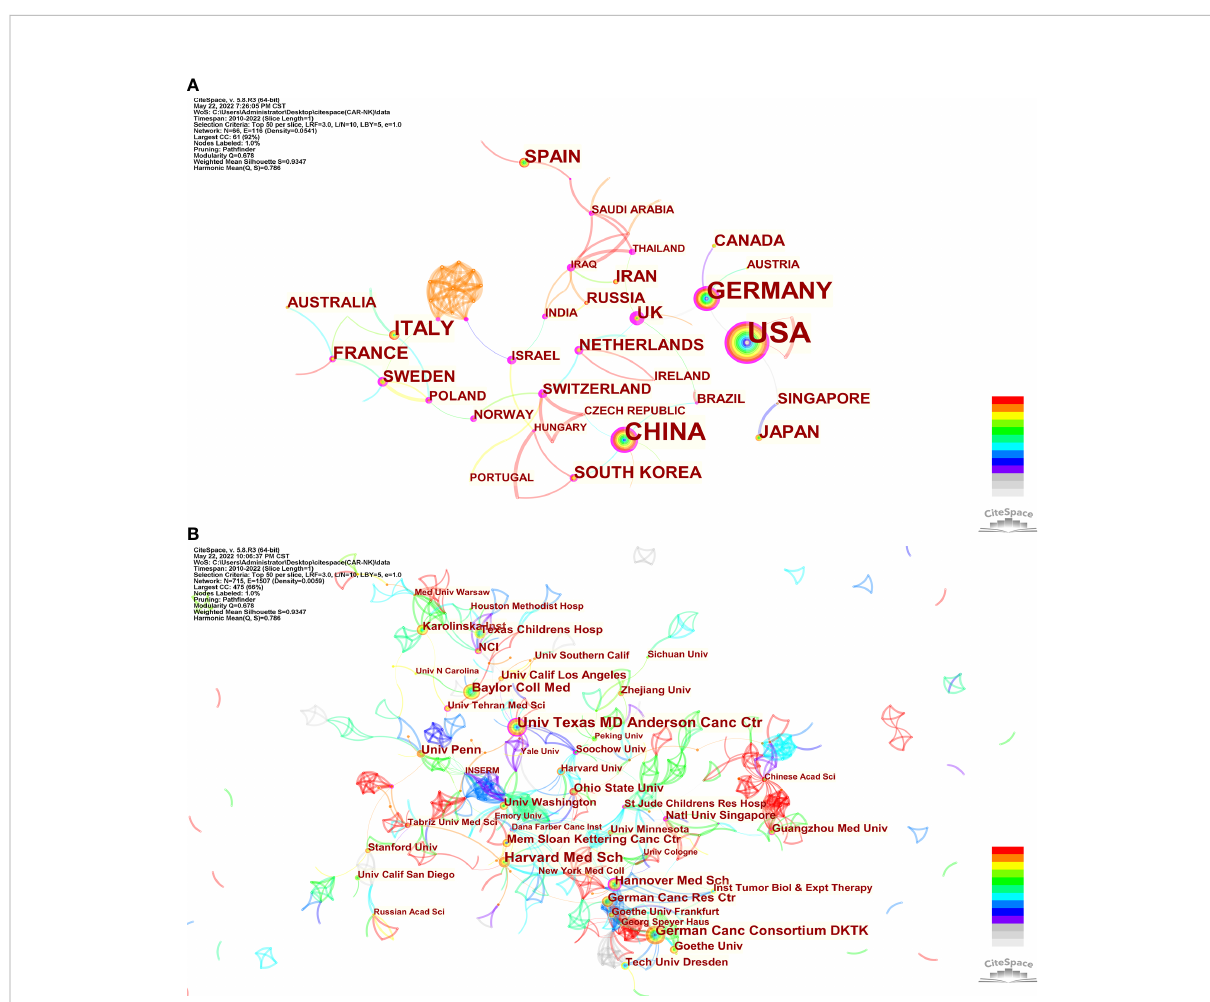
FIGURE 2 The co-occurrence map of countries (A) and institutions (B) in the CAR-NK cell fi